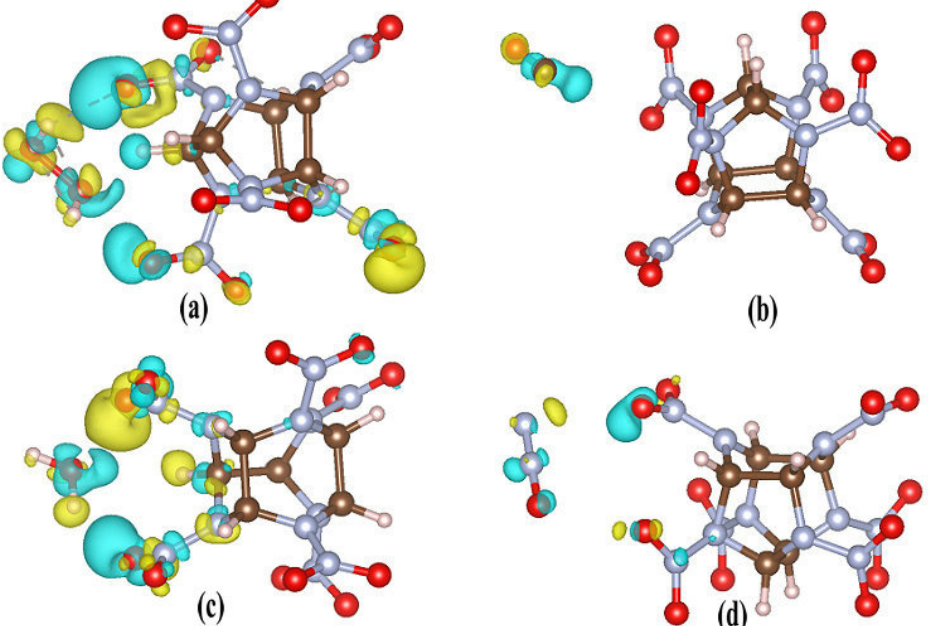
Figure 14. The differential charge density of CL-20 and its complexes: ( a ) CL-20/H 2 O 2 , ( b ) CL- 20/CO 2 , ( c ) CL-20/H 2 O, and ( d ) CL-20/N 2 O, respectively. The isosurface value is set to 0.006 e·Å − 3 . Yellow represents charge accumulation.